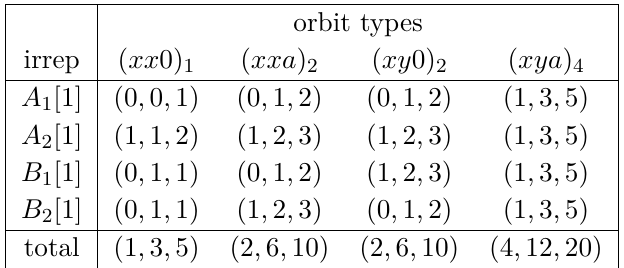
Table 12. As for table 10 but for frames with d ref = ( n, n, 0) . See table 6 for orbit-type composi-